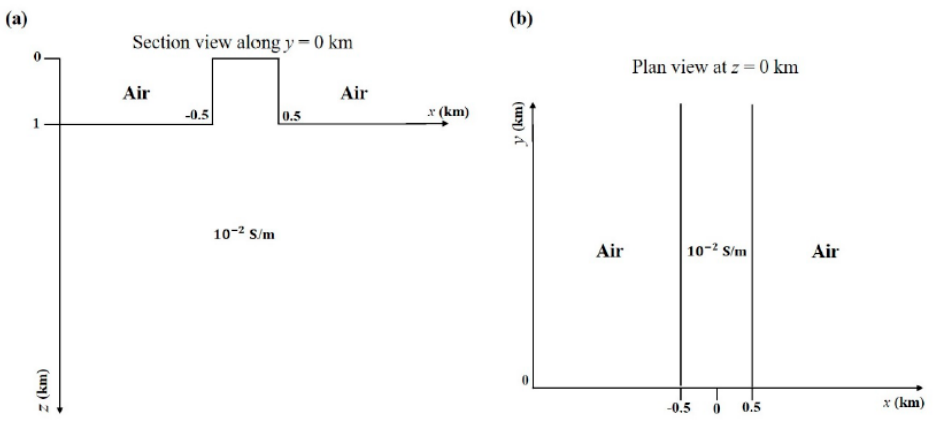
Figure 9. Sketch of the steep hill model. ( a ) x - z section view along y = 0, ( b ) x - y plan view at z = 0.